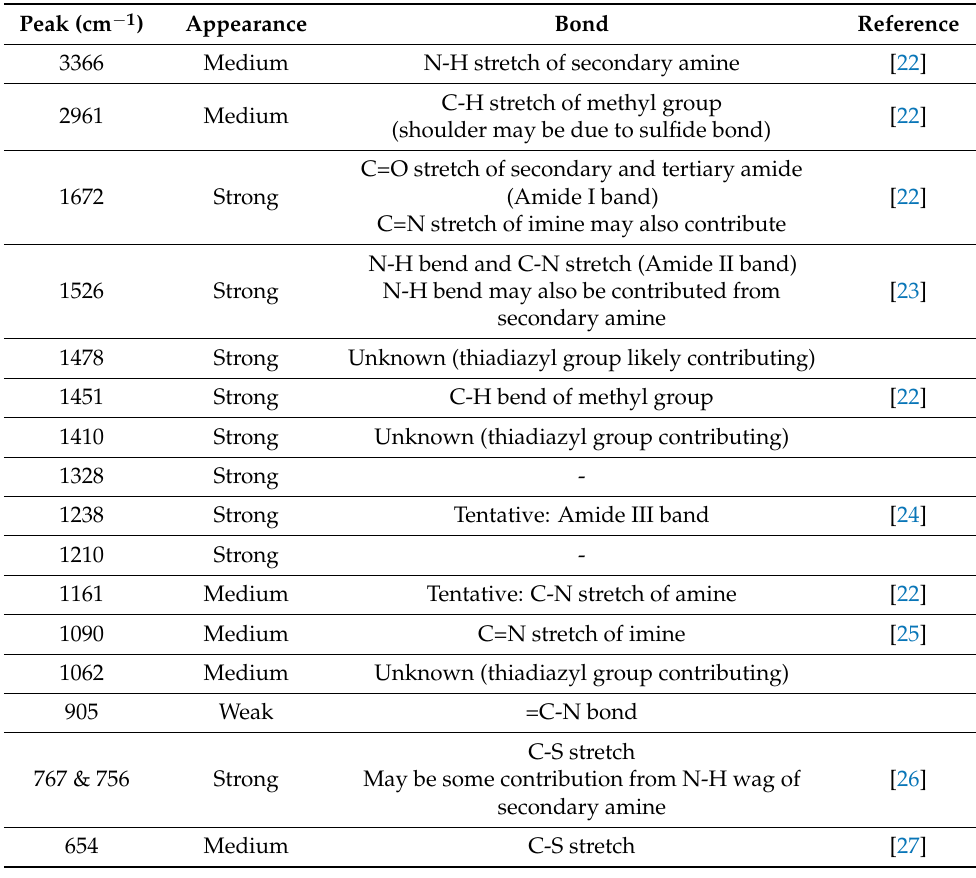
Table 5. The major peaks observed in the FTIR spectrum of pure tebuthiuron powder and their assigned bonds.